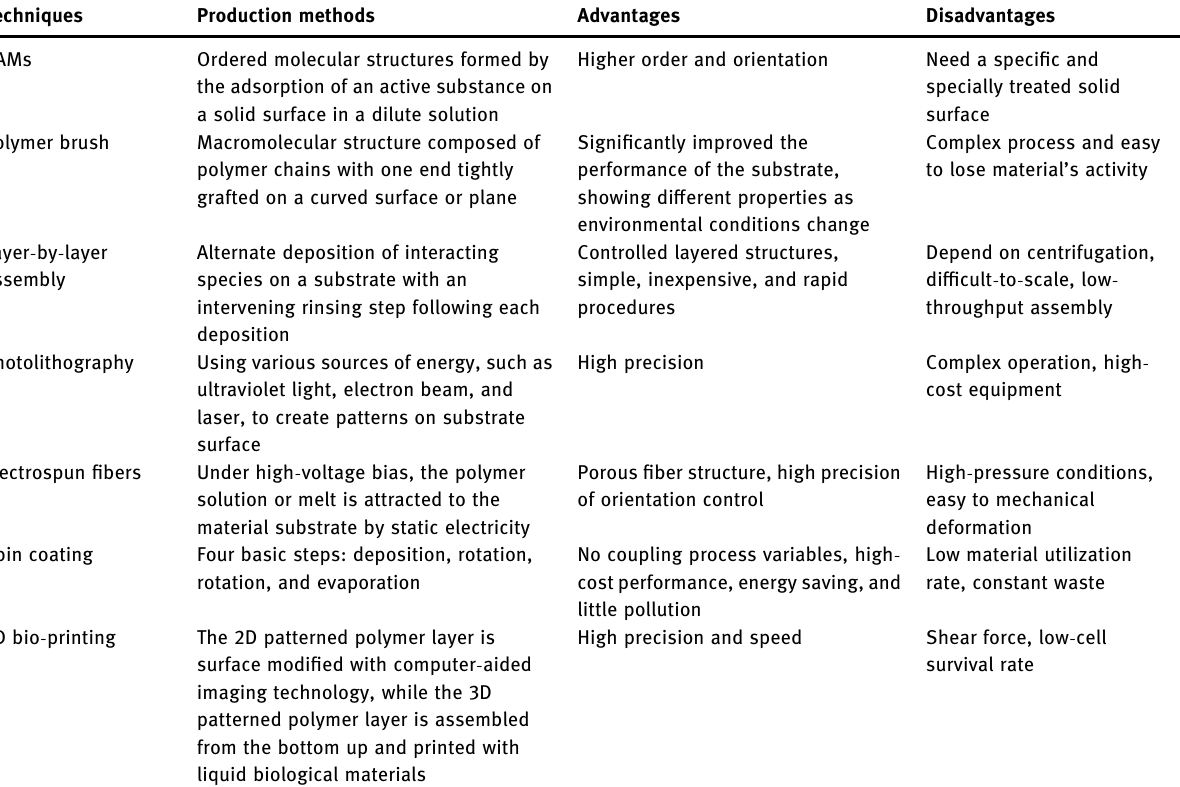
Table 1: Methods of creating cell adhesion surfaces